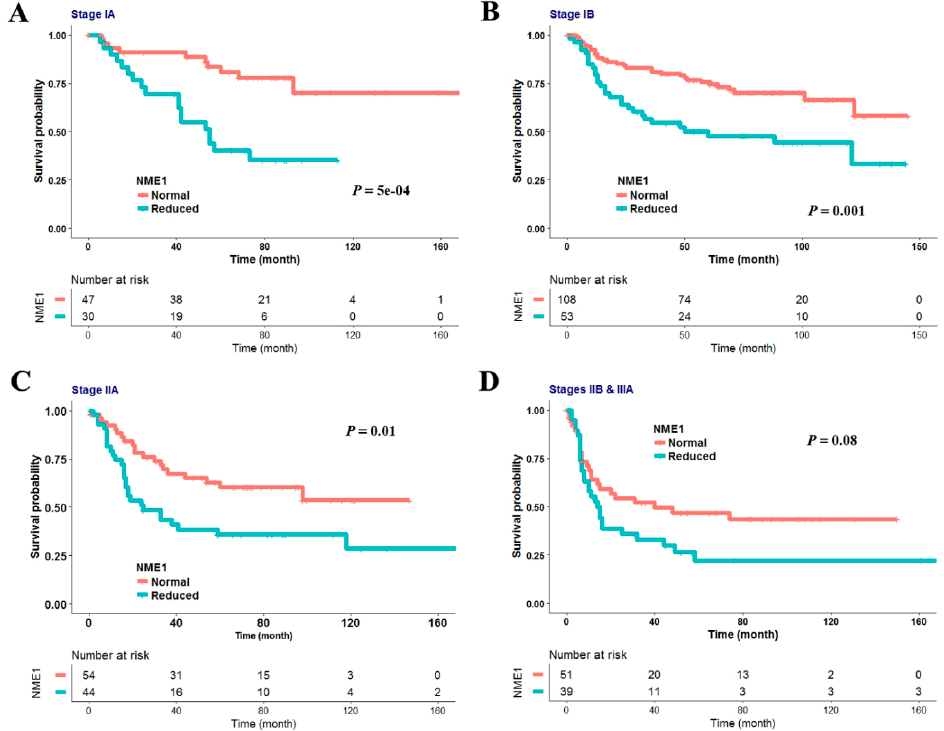
Figure 2. Impact of NME1 on recurrence-free survival (RFS) according to pathologic stages. The e ff ect of reduced NME1 expression on RFS was estimated using the Kaplan–Meier survival curve in 77 patients with stage IA ( A ), 161 with stage IB ( B ), 98 with stage IIA ( C ), and 89 stage IIB–IIIA ( D ). Statistical di ff erence between two survival curves was calculated using the log-rank